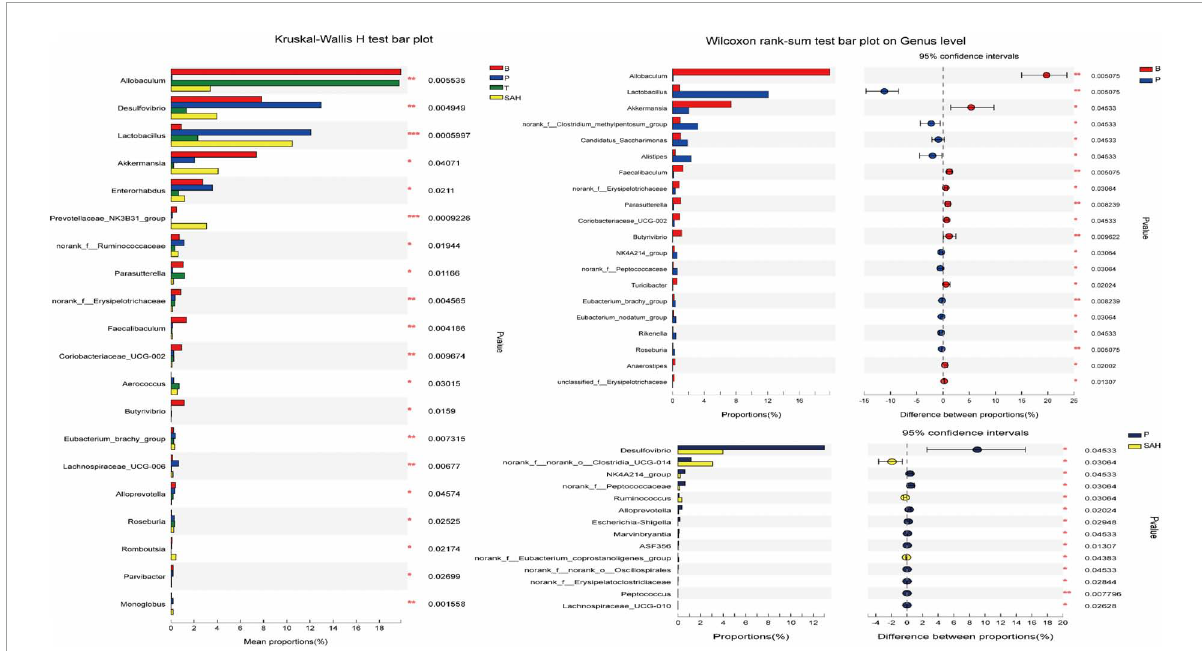
FIGURE8 Comparisons between different groups at the genus level. y -axis indicates species name at a given taxonomic level, x -axis indicates mean relative abundance in different groups of species, different colors indicate different groups; rightmost P , *0.01 & P ≤ 0.05, **0.001 & P ≤ 0.01, *** P ≤ 0.001. Data were presented as the mean ± SD ( n = 6). B, control group; P, diabetic model group; T, (HFD + 200 mg kg – 1 Met); SAH, (HFD + 280 mg kg – 1